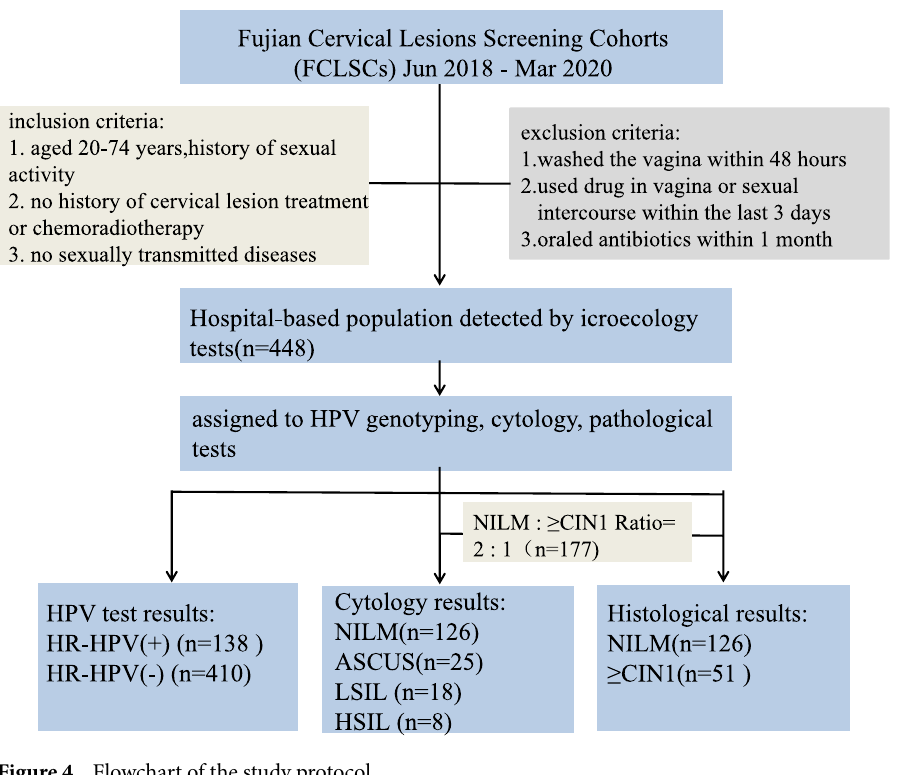
Figure 4. Flowchart of the study